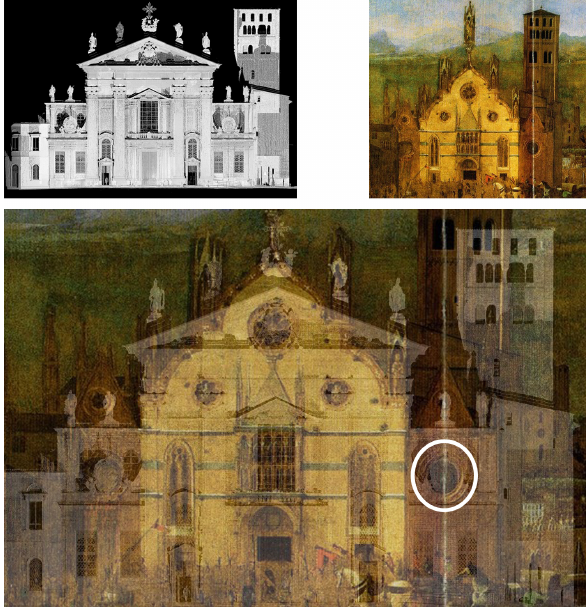
Figure 5. Top left: orthophoto of the fac¸ade generated in Cyclone from pointlcouds. Top right: portion of a painting made by Domenico Morone in 15th Century, representing the Gothic fac¸ade. Bottom: Superposition of the top images, the circular window previously found and descripted on Fig. 4 is here marked with a white